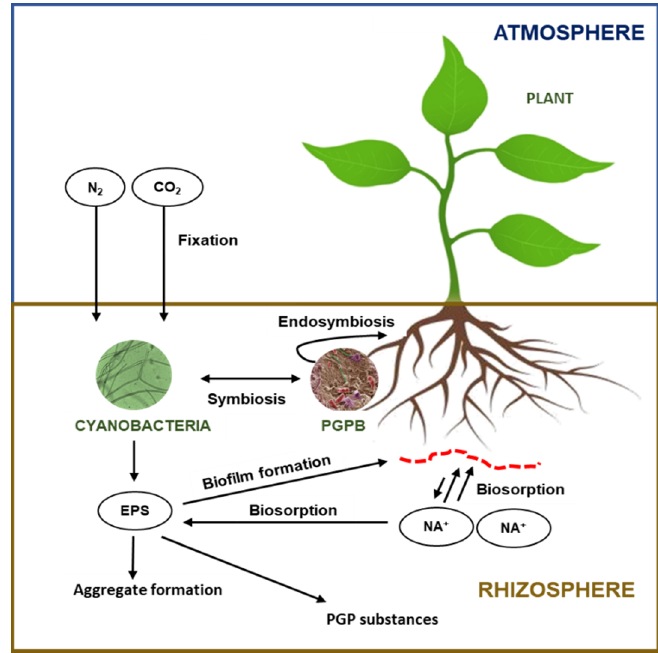
Figure 2. Mechanisms of salt-affected soil remediation by cyanobacteria. Cyanobacteria produce EPS. EPS form biofilms with other microorganisms and biosorpt sodium (Na + ). EPS enhance soil aggregation and produce plant-growth promoting (PGP) substances. Cyanobacteria fix nitrogen (N 2 ) and capture carbon dioxide (CO 2 ). Cyanobacteria form symbiotic relationships with other plant-growth promoting bacteria (PGPB) which in turn form endophytic and rhizospheric associations with plants.